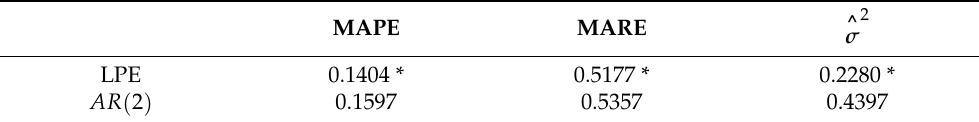
Table 3. Values of evaluation metrics form the estimated semiparametric and AR ( 2 ) models.